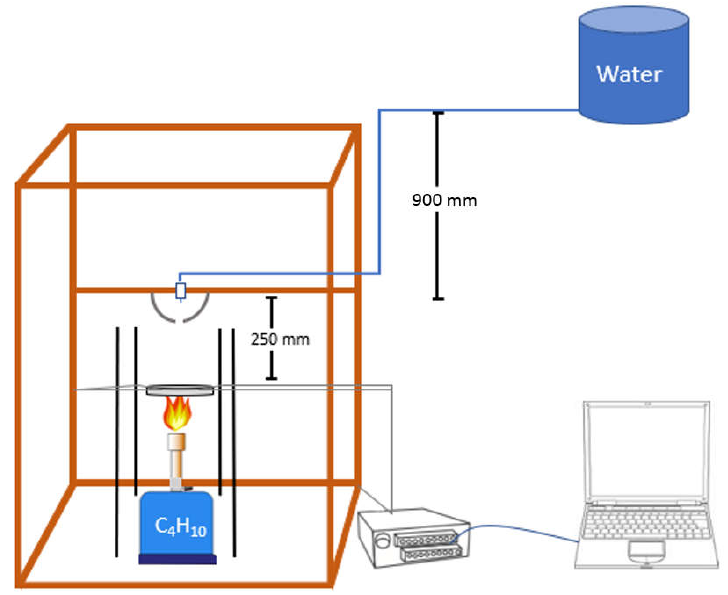
Figure 3. Sketch of the experimental setup (not to scale).